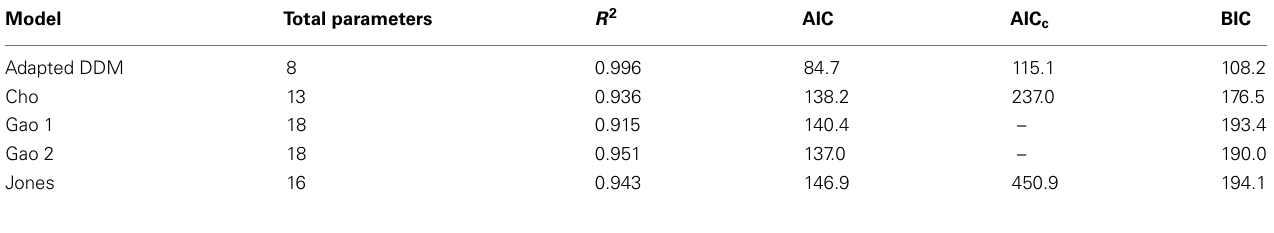
Table 2 | Model performance